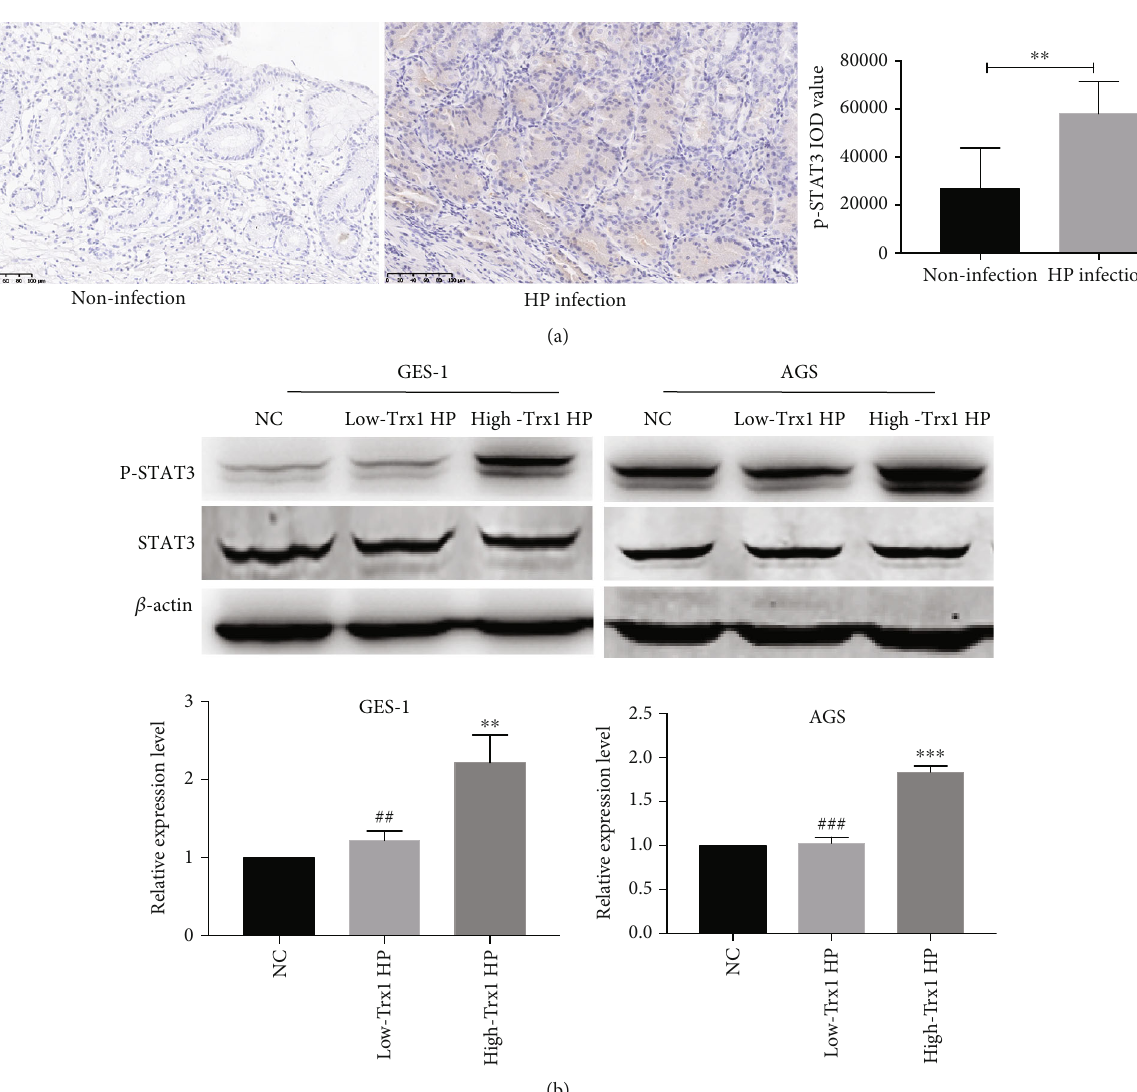
Figure 4: The high-Trx1 HP can cause higher expression of p-STAT3. (a) Representative immuno-histochemical pictures and statistical graph of p-STAT3 in noninfection gastric mucus ( n = 8 ) and HP infection gastric mucus ( n = 8 ). (b) The p-STAT3 expression of GES-1 and AGS cells during low-Trx1 HP and high-Trx1 HP infection was detected by Western blot. Note: NC means uninfected control group, low-Trx1 HP means HP with low Trx1 expression, and high-Trx1 HP means HP with high Trx1 expression, ∗∗ P < 0 : 01 , ∗∗∗ P < 0 : 001 , ## P < 0 : 01 , and ### P < 0 : 001